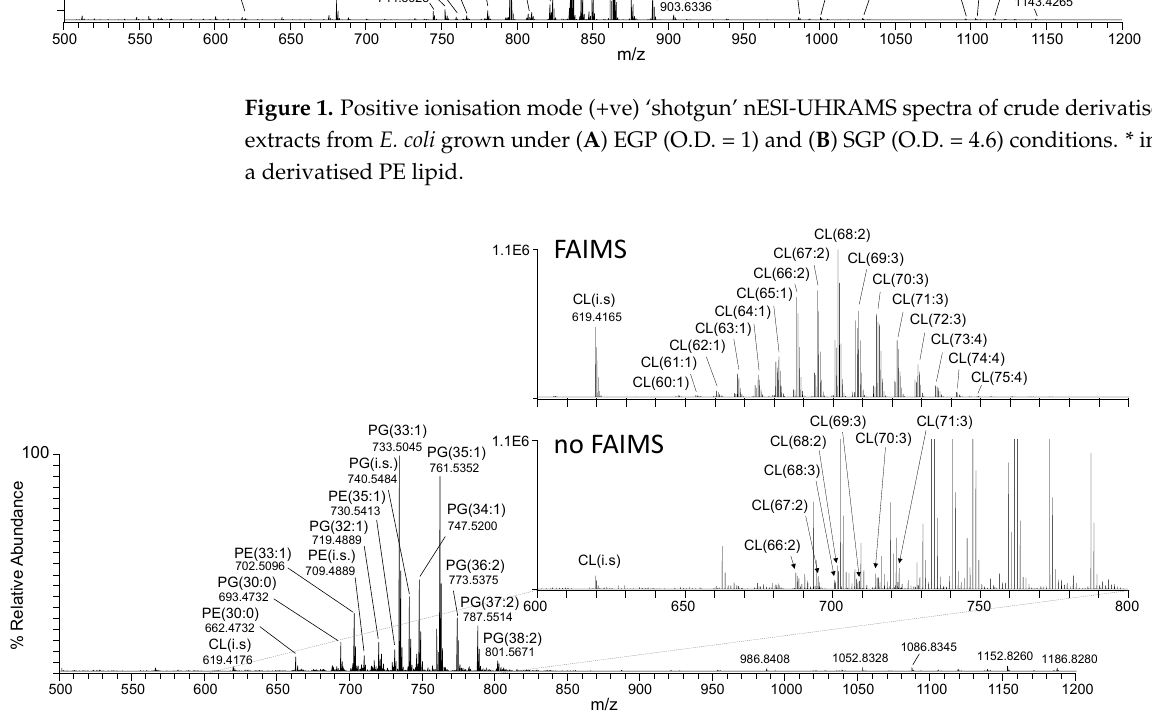
Figure 2. Negative ionisation mode (-ve) ‘shotgun’ nESI-UHRAMS spectra of a crude non-derivatised lipid extract from E. coli grown under SGP conditions. The lower inset shows an expanded region (600–800 m/z ) of the mass spectrum. The upper inset shows an expanded region (600–800 m/z ) of the mass spectrum acquired using nESI-FAIMS-UHRAMS on the same sample. Following data analysis and quantitation against the respective internal lipid stand- ards, a total lipid content of 121.3 mg and 80.3 mg of PE, PG and CL lipid per g of protein was determined for the EGP and SGP cells, respectively (Figure 3A,B, respectively), with the most abundant lipid class being PE (74.4% and 72.5% in EGP and SGP, respectively), followed by PG (20.9% and 22.4%). The observed decrease in total lipid content under SGP conditions is likely to be due to some of the cellular population entering into the cell death phase, as well as a loss of total lipid content due to catabolic lipid metabolism in response to nutrient depletion stress. Between the EGP and SGP conditions, the abundance of the PE and PG lipid classes did not undergo any major changes, while CL underwent a sig- nificant increase from 2.9% to 4.4%. However, there was a significant change observed in